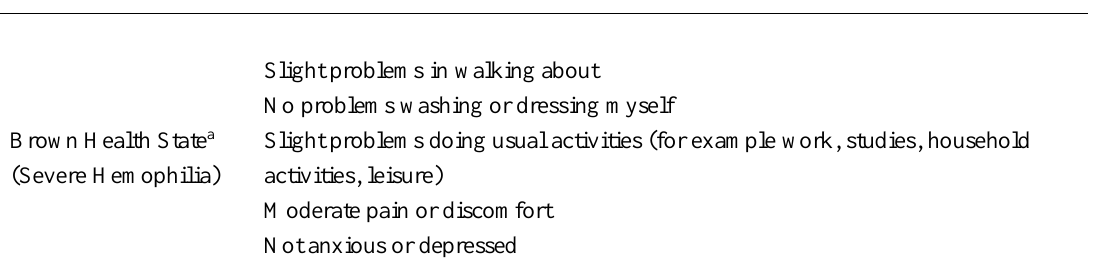
happy smiley. The orange health state was illustrated by using an orange, sad smiley. The brown health state was illustrated by using a brown, sad